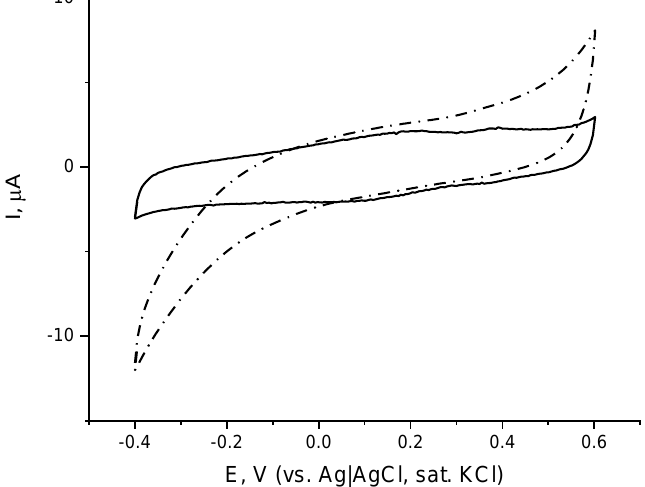
Figure 2. Cyclic voltammograms (second scan) of laccase immobilized on chemisorbed monolayer of cystamine in background electrolyte in aerated (dash) and de-aerated with Ar medium (solid), 0.05 M citrate buffer containing 0.1 M NaClO 4 , pH = 4.0; scan rate, v = 5 mV/s, reference electrode Ag|AgCl, sat. KCl.